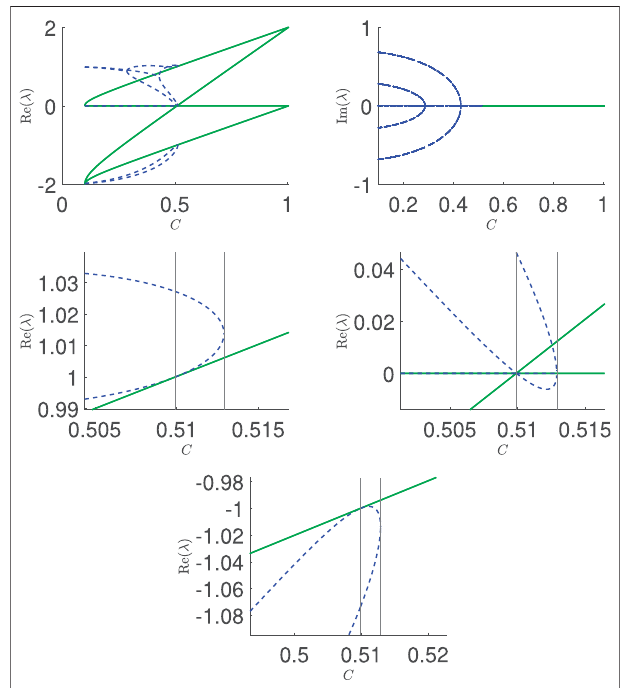
FIGURE 7 | Eigenvalues of the asymmetric (and lower symmetric) branches as a function of (control) parameter C . Top left: real part; top right: imaginary part. The second and third row show details of the individual eigenvalues in the vicinity of the bifurcation points C ( 1 ) cr (cid:2) 0 . 51 (transcritical) and C ( 2 ) cr (cid:2) 0 . 5128 (SN), marked by thin black lines. Once again green(solid)linesareusedforthelowersymmetricbranch,whiledashed(blue) ones for the asymmetric branches. See the text for further